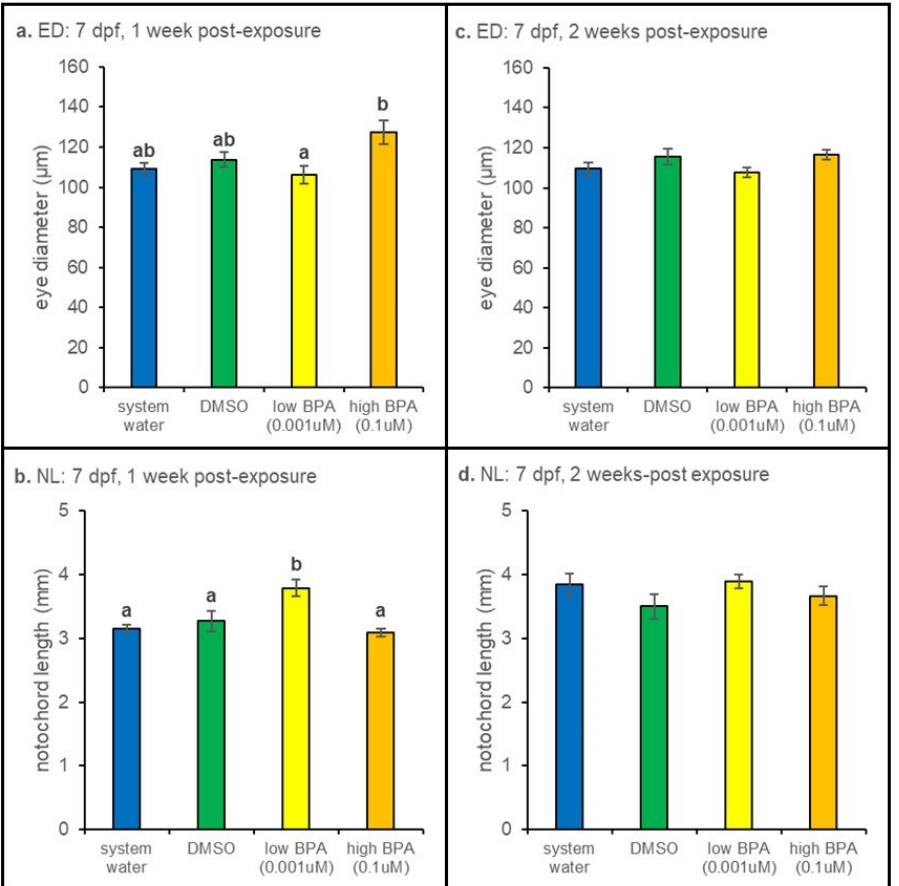
Figure 4. Seven days postfertilization anatomical measurements. ( a ) Compared to controls, eye diameter was not increased in either BPA group after 1 week of recovery, though the high BPA exposure group had significantly larger eyes than the low BPA exposed larvae ( p = 0.022). ( b ) After 1 week of recovery, notochord length was significantly increased larvae exposed to low BPA ( p < 0.001). No significant differences were noted after 2 weeks of recovery for either ( c ) eye diameter or ( d ) notochord length. At each recovery point n = 5 for all treatment groups except for DMSO, in which n = 4. Differences in notochord length and eye diameter across treatment were assessed using a one-way ANOVA followed by a Tukey post hoc test at each exposure age. Eye diameter measurements were normalized to notochord lengths prior to statistical analysis. All values are reported as mean ± SE. Different letters denote significance.